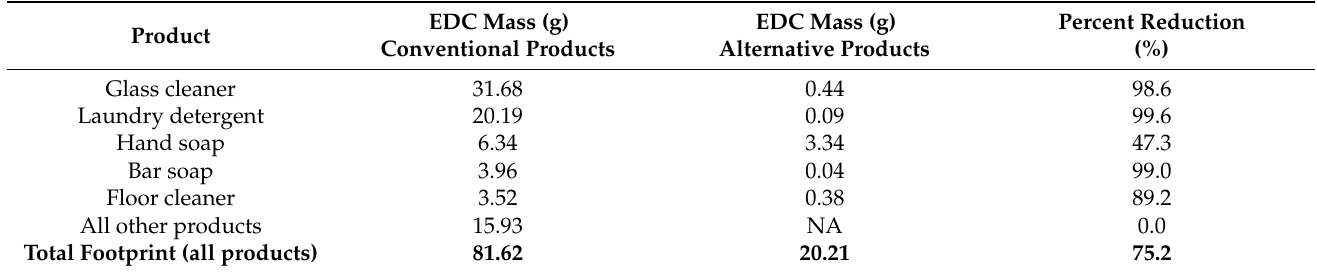
Table 3. Potential endocrine-disrupting compound (EDC) footprint reduction that could be achieved by replacing the top five contributing products with a greener alternative for one example